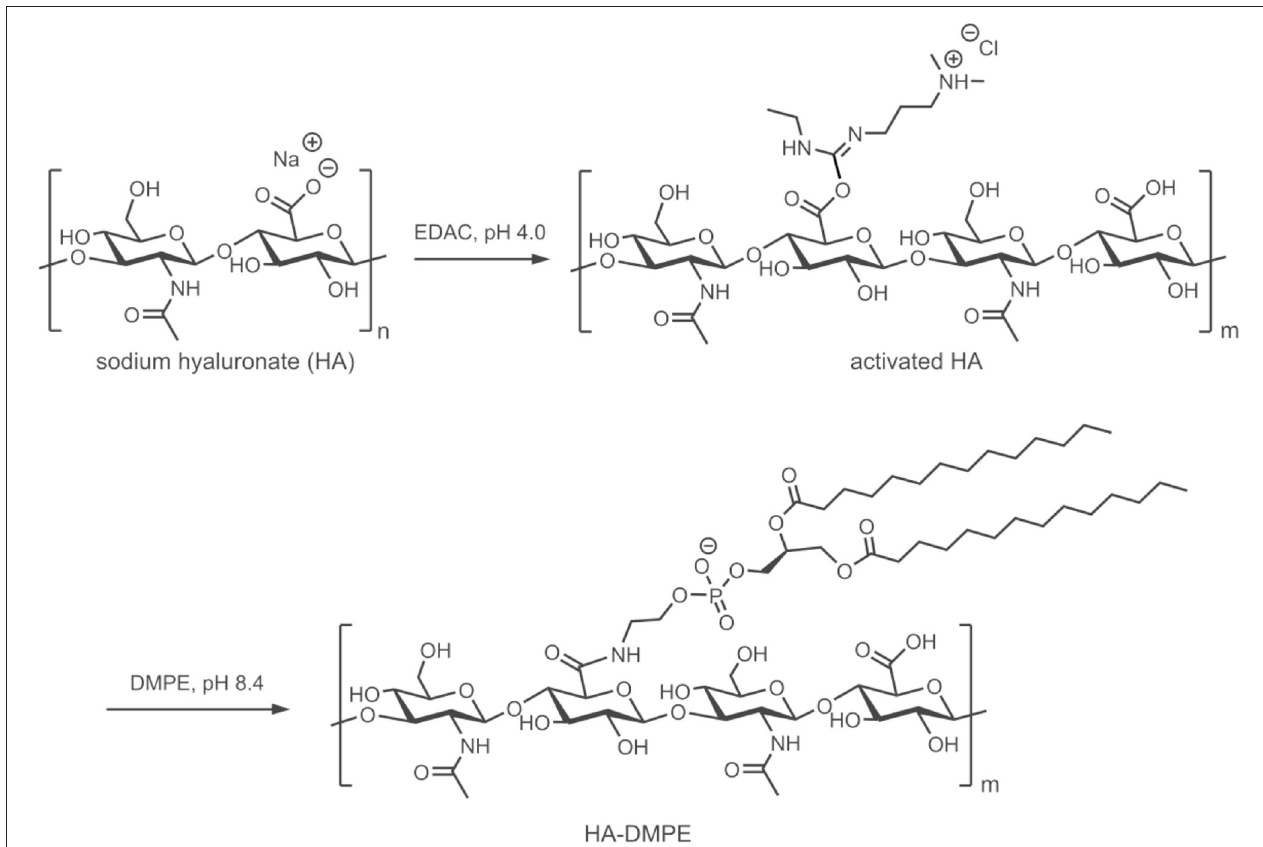
FIGURE 1 | Schematic representation of the preparation of the HA-DMPE conjugate. The preparation of the HA-DPPE conjugate follows an identical procedure, with the exception that DPPE is used instead of